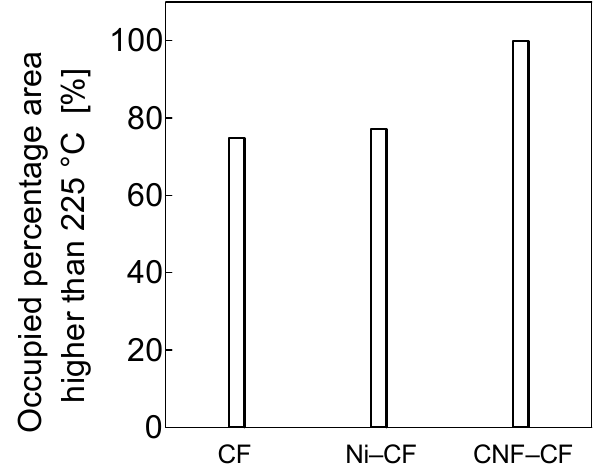
Figure 11. Temperature history of each carbon nanofilaments.